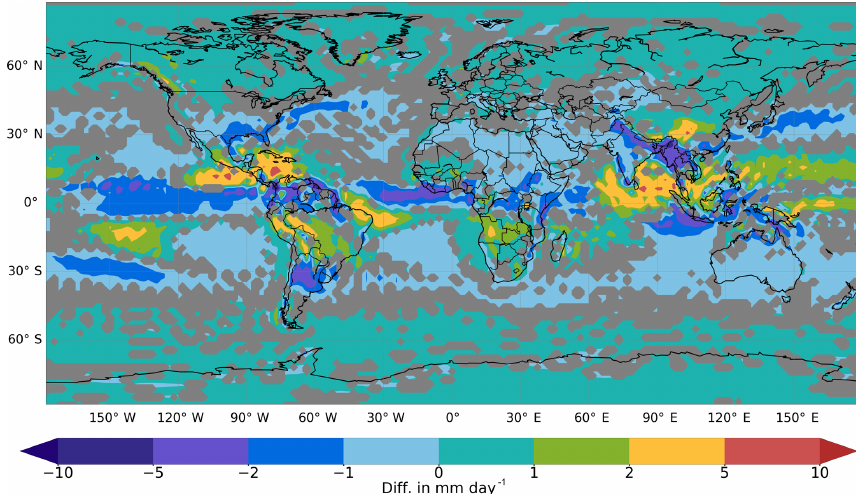
Figure 13. Decadal mean bias of total precipitation in ECHAM6.3 compared to the ECMWF ERA-Interim reanalysis (Dee et al., 2011). Gray shading denotes areas that are not significant according to a t test (95% confidence interval). Figure regenerated from data described in Krefting (2017). Table 7. Global tropospheric NO x budgets of the four ECHAM-HAMMOZ simulations described in Table